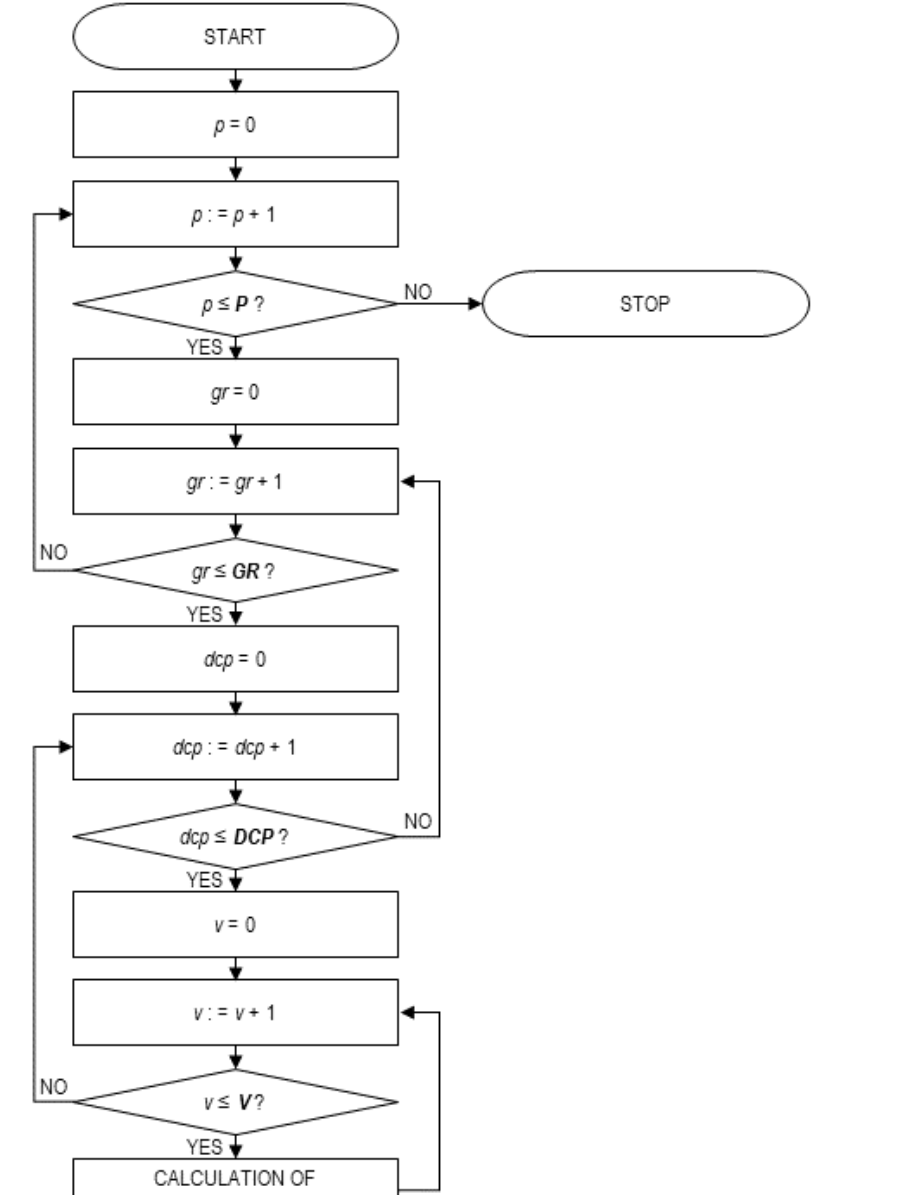
Figure 5. Procedure for calculating the energy efficiency of an asynchronous motor. Source: own work.